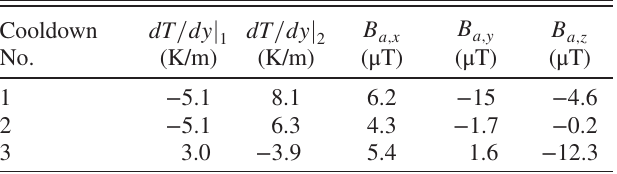
TABLE III. Ambient magnetic field at the cavity equator ring and temperature gradient at either side of the equator ring when ¼ 17 . 7 – 17 . 8 K for each of the three cooldowns. The x , y T avg and z directions are shown in Fig. 20.